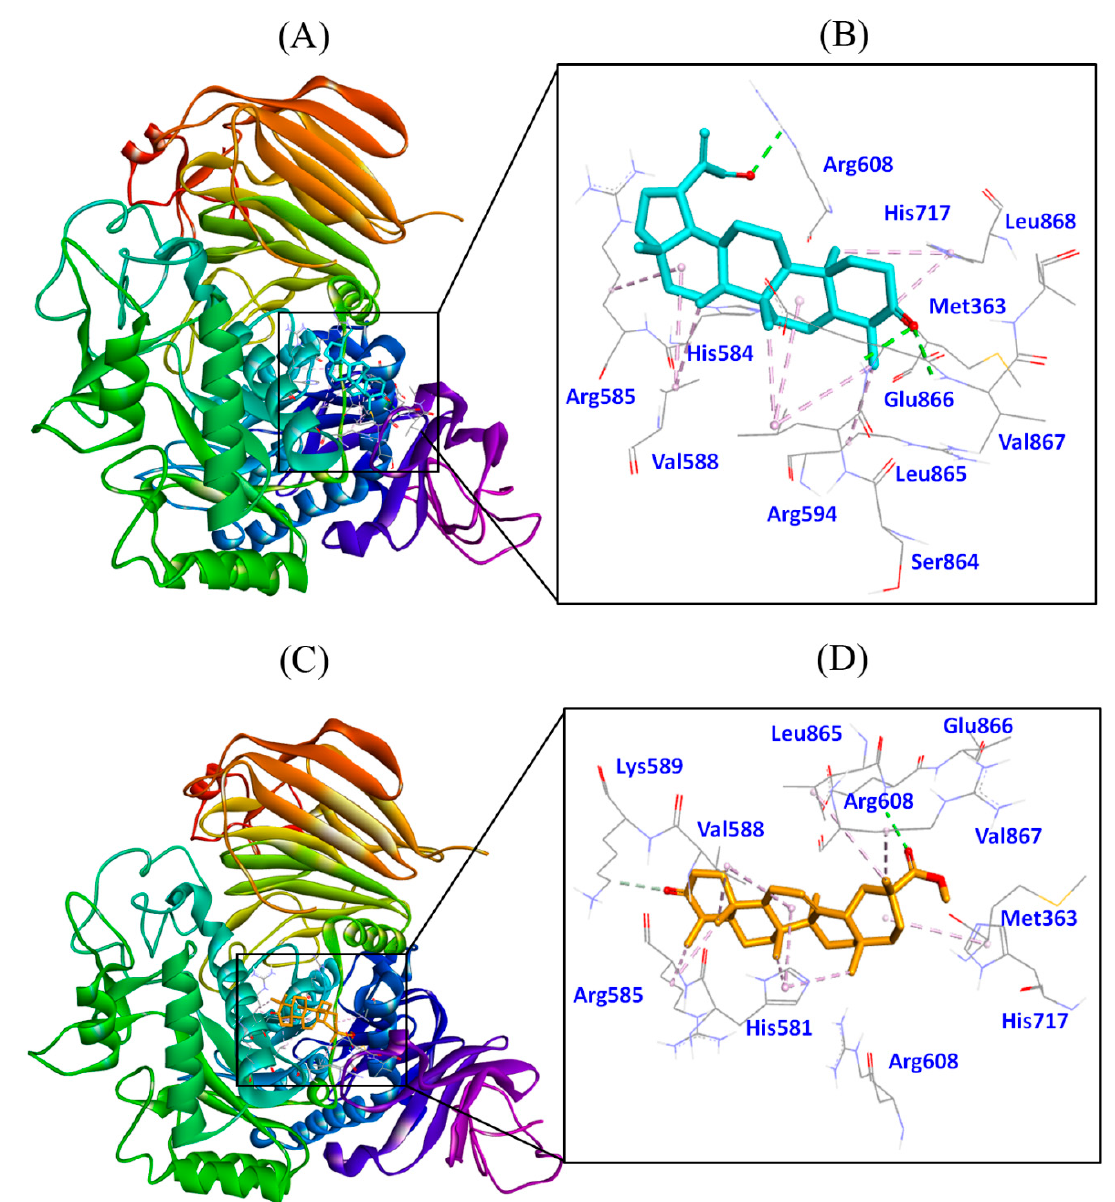
Figure 7. Molecular docking of 3-oxolupenal and katononic acid with α -glucosidase. ( A ) Binding of 3-oxolupenal with α -glucosidase, ( B ) amino acid residues and various interactions involved in 3-oxolupenal- α -glucosidase complex, ( C ) binding of katononic acid with α -glucosidase, and ( D ) amino acid residues and various interactions involved in katononic acid- α -glucosidase complex.